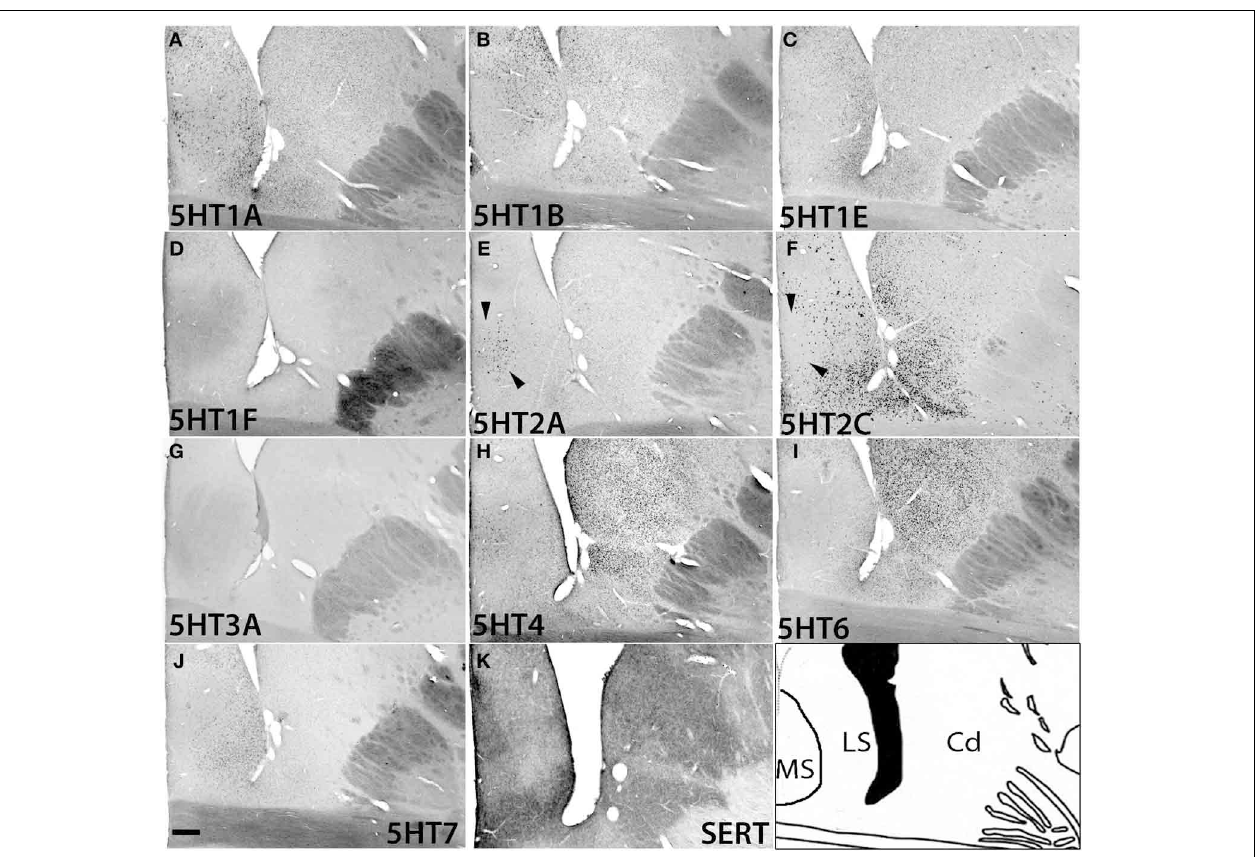
FIGURE 12 | ISH expression profiles of 5HTR s in caudate and septum. 5HTR mRNA expressions (A–J) and immunohistochemical staining with anti-SERT antibody (K) in the caudate (Cd) nucleus, and medial septum (MS), and lateral septum (LS). Note that the